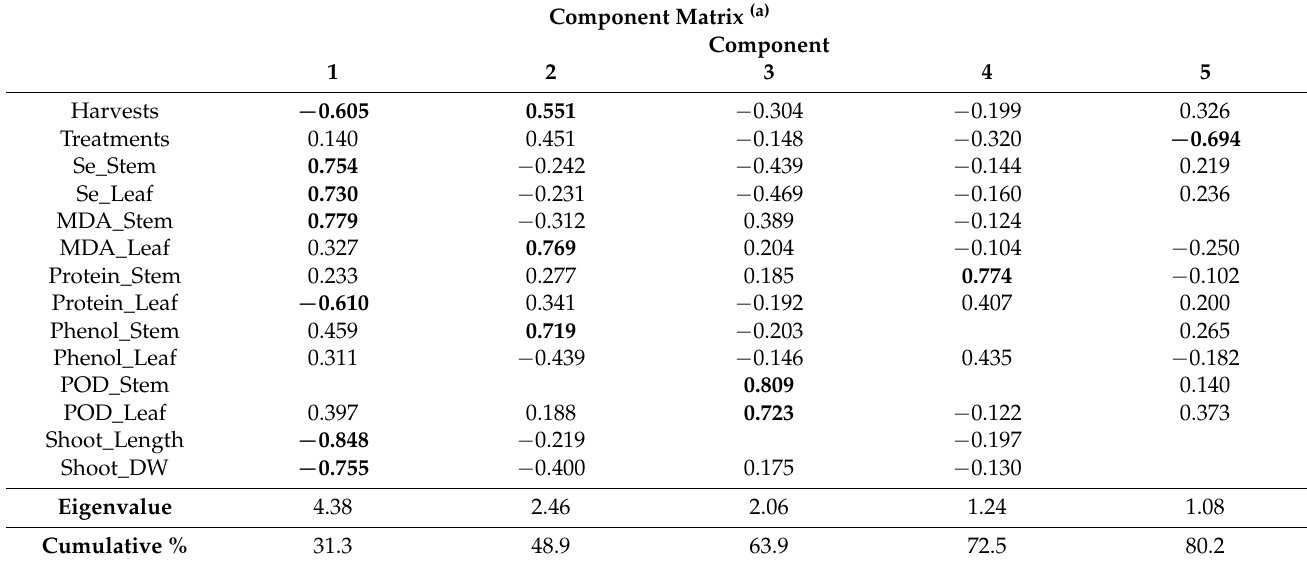
Figure 4. Principal component analysis of the morphological, chemical and biochemical properties of alfalfa fertilized with different Se forms (i.e., Se (VI), Se (IV), and red Se 0 ) at different concentrations (1, 10, and 50 mg kg −1 for ionic forms and 10 and 50 mg L −1 for red Se 0 ). Data are means ( n = 6). Table 4. Rotated loading values for the first five PCs from the measured properties of alfalfa grown on different selenium (Se) forms (Se (VI), Se (IV), and red Se 0 ) and concentrations (1, 10, and 50 mg kg − 1 for ionic forms and 10 and 50 mg L − 1 for elemental form) during four consecutive harvests (in bold significant values p <